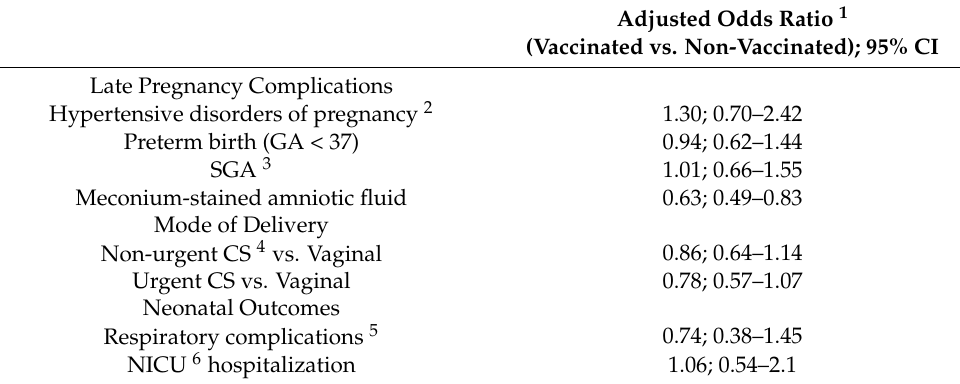
Table 4. Obstetric and neonatal outcomes multivariable